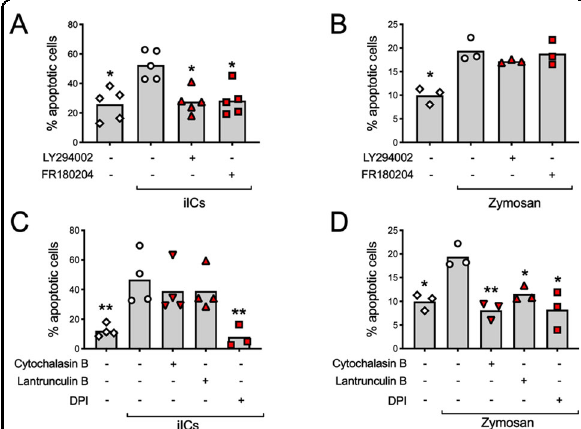
Fig. 3 iIC-induced neutrophil apoptosis is not PICD. Neutrophils were pre-incubated with small molecule inhibitors or vehicle at 37 °C for 10 min as indicated, stimulated with ( A , C ) 10 μ g/ml iICs (HSA anti- HSA) or ( B , D ) 3 zymosan particles/neutrophil in IMDM supplemented with 10% autologous serum and cultured at 37 °C for 12 h in a humidi fi ed, CO 2 -controlled incubator prior to labelling with annexin V and propidium iodide. The percentage of apoptotic cells is recorded. Each symbol represents the average value obtained in a separate experiment. Raw data were analyzed by Kruskal – Wallis test and multiple comparison post-hoc test. * p < 0.05; ** p <